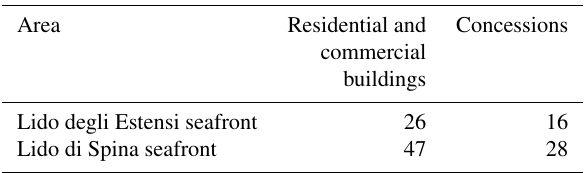
Table 4. Distribution of the receptors at Lido degli Estensi and Lido di Spina.